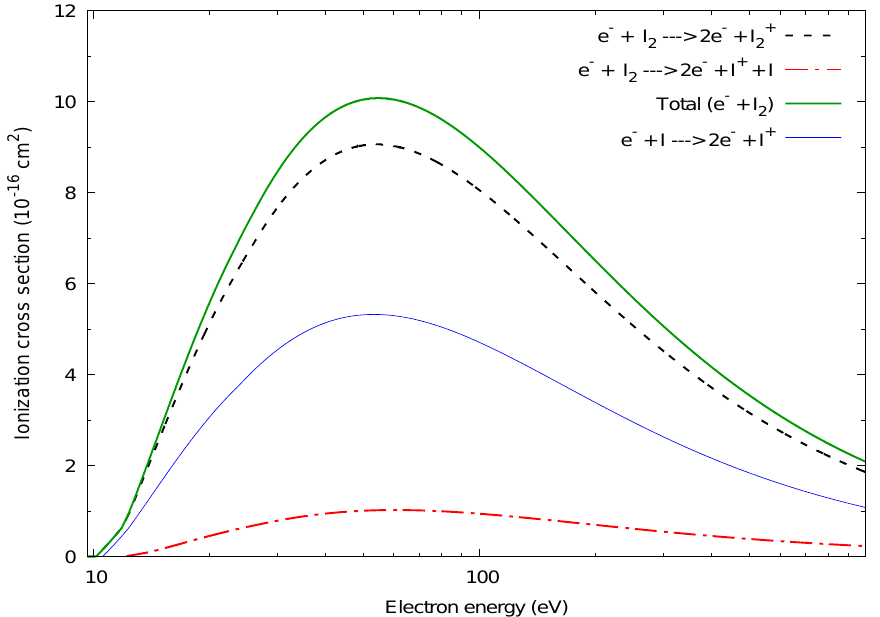
Figure 8. Electron-impact ionization cross section obtained for I and I 2 . Also shown are the partial ionization cross sections for I 2 leading to products I +